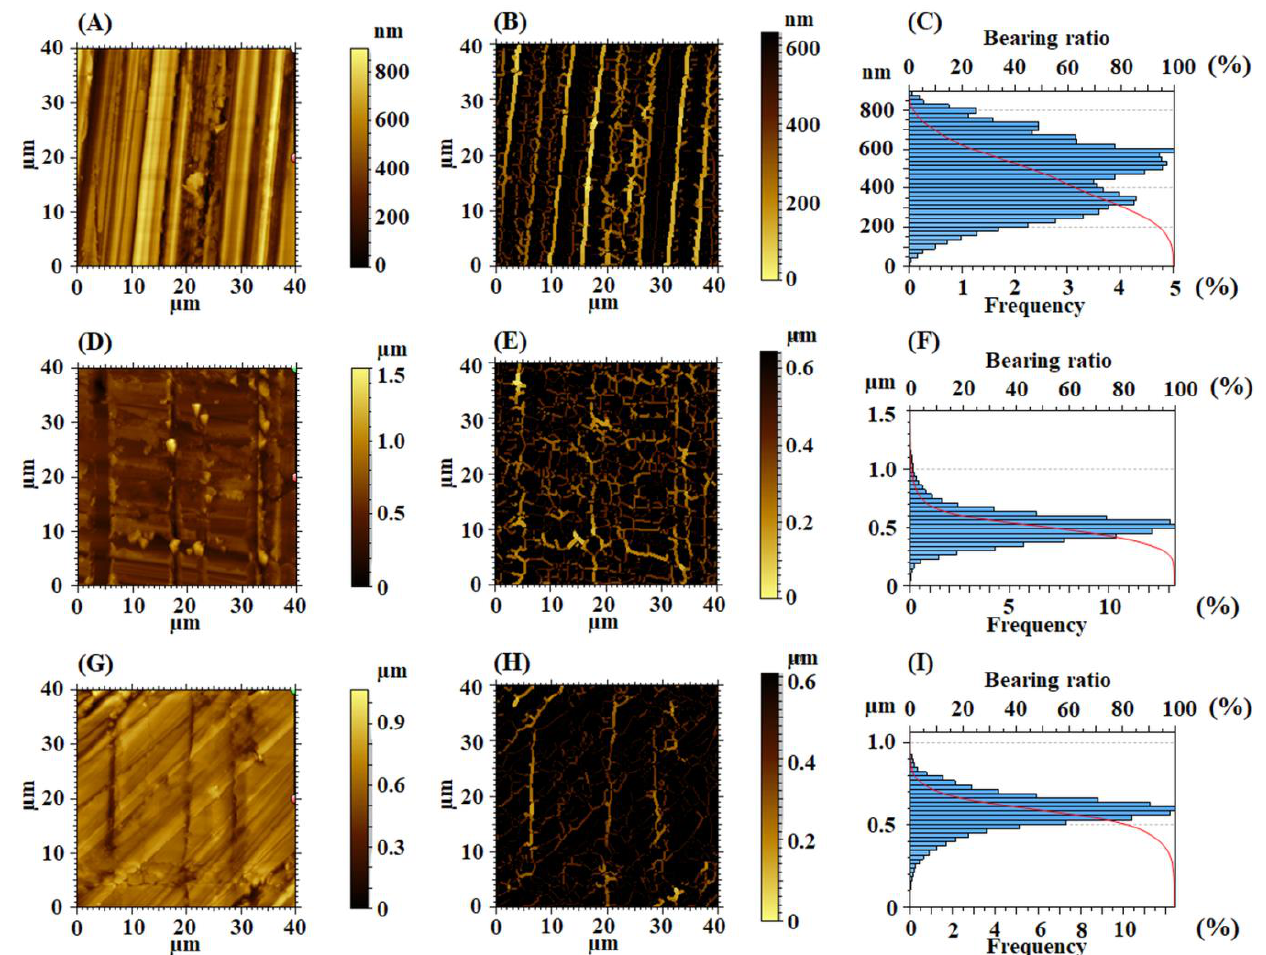
Figure 6. 2D topographical images, furrow maps and histograms/Abbott curves obtained for rubbed EPI-pBAPS (1R) ( A – C ), EPI-pBAPS (2R) ( D – F ) and EPI-pBAPS (3R) ( G – I ) samples.